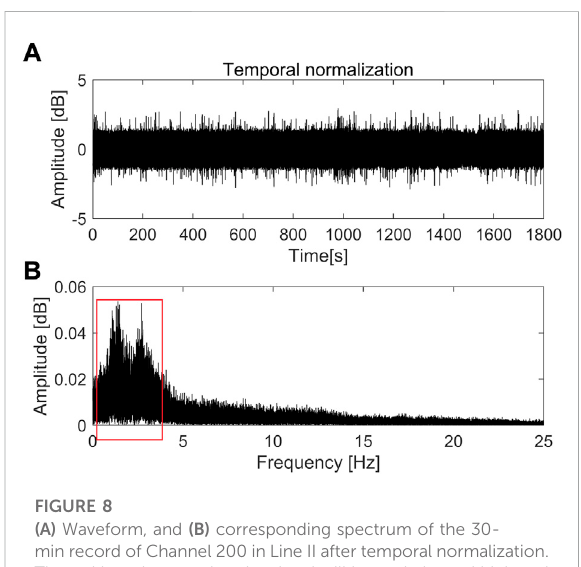
FIGURE 8 (A) Waveform, and (B) corresponding spectrum of the 30- min record of Channel 200 in Line II after temporal normalization. The red box denotes that the signal still has unbalanced high and low-frequency energy after the temporal normalization.